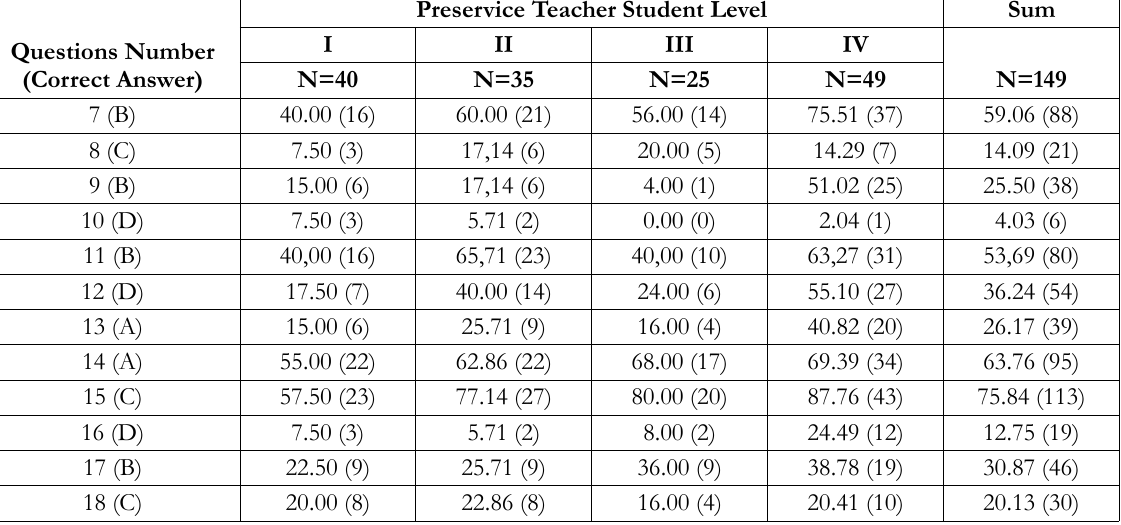
Table 4. Percentage of preservice teachers’ answers correctly on question no. 7-18